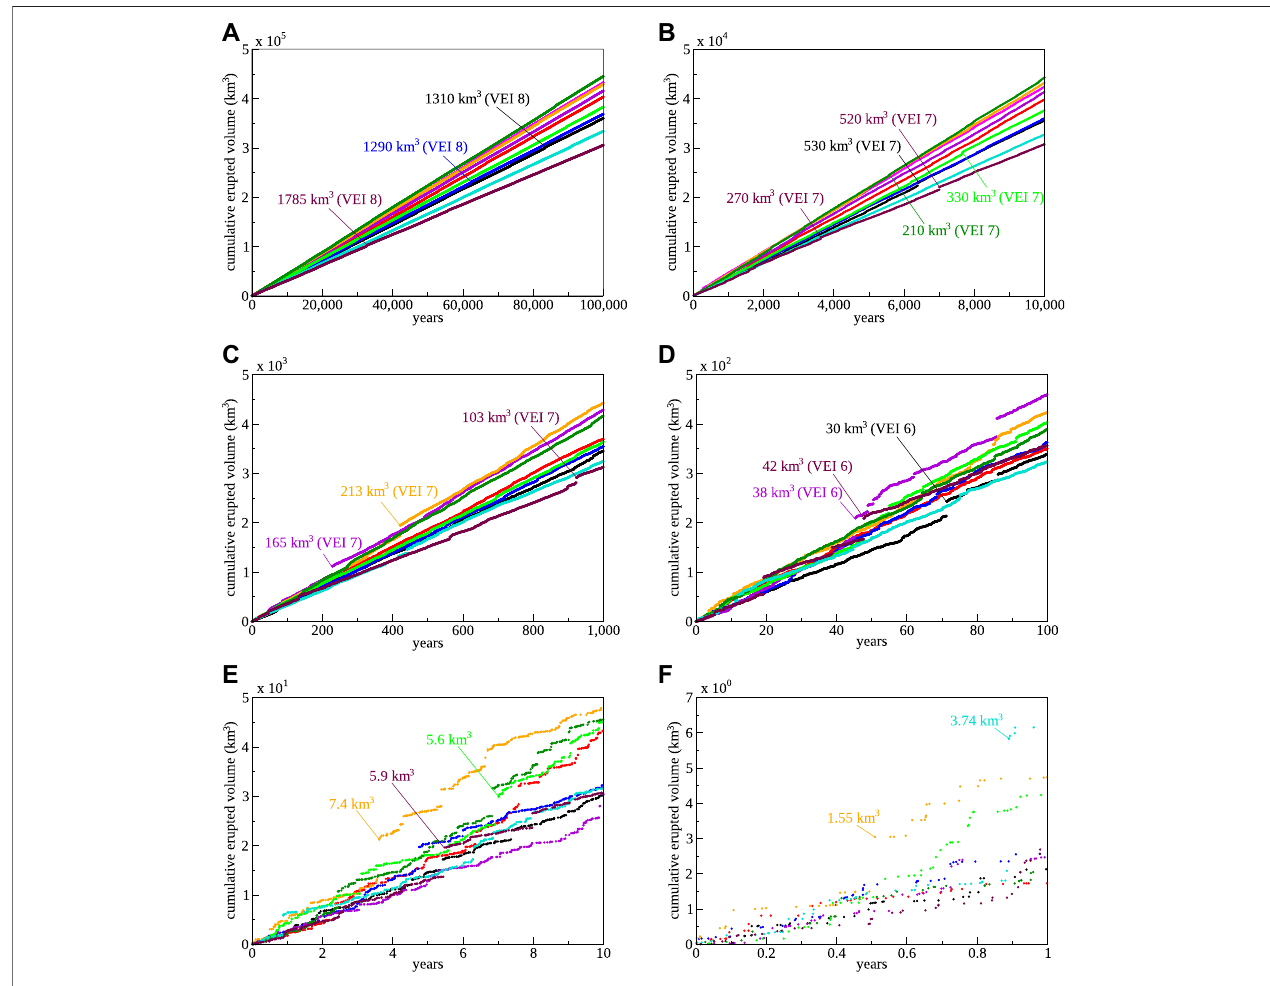
FIGURE4 | Ten random simulations, indifferent colors, out of1000 performed simulations, each 100,000 years long, ofthe globalsubaerial eruptive history of the Earth. Panel (A) shows the entire length of simulations, each one consisting of > 4 million individual eruptions. Panels (B-F) are zoom views of the initial 10,000 to 1 year. Some of the largest visible eruptions are indicated in each panel, together with their corresponding volume and, for VEI ≥ 6, their corresponding VEI.